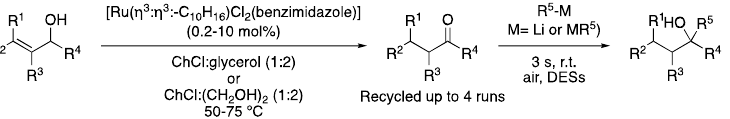
Figure 37. Ru-catalyzed isomerization reaction.